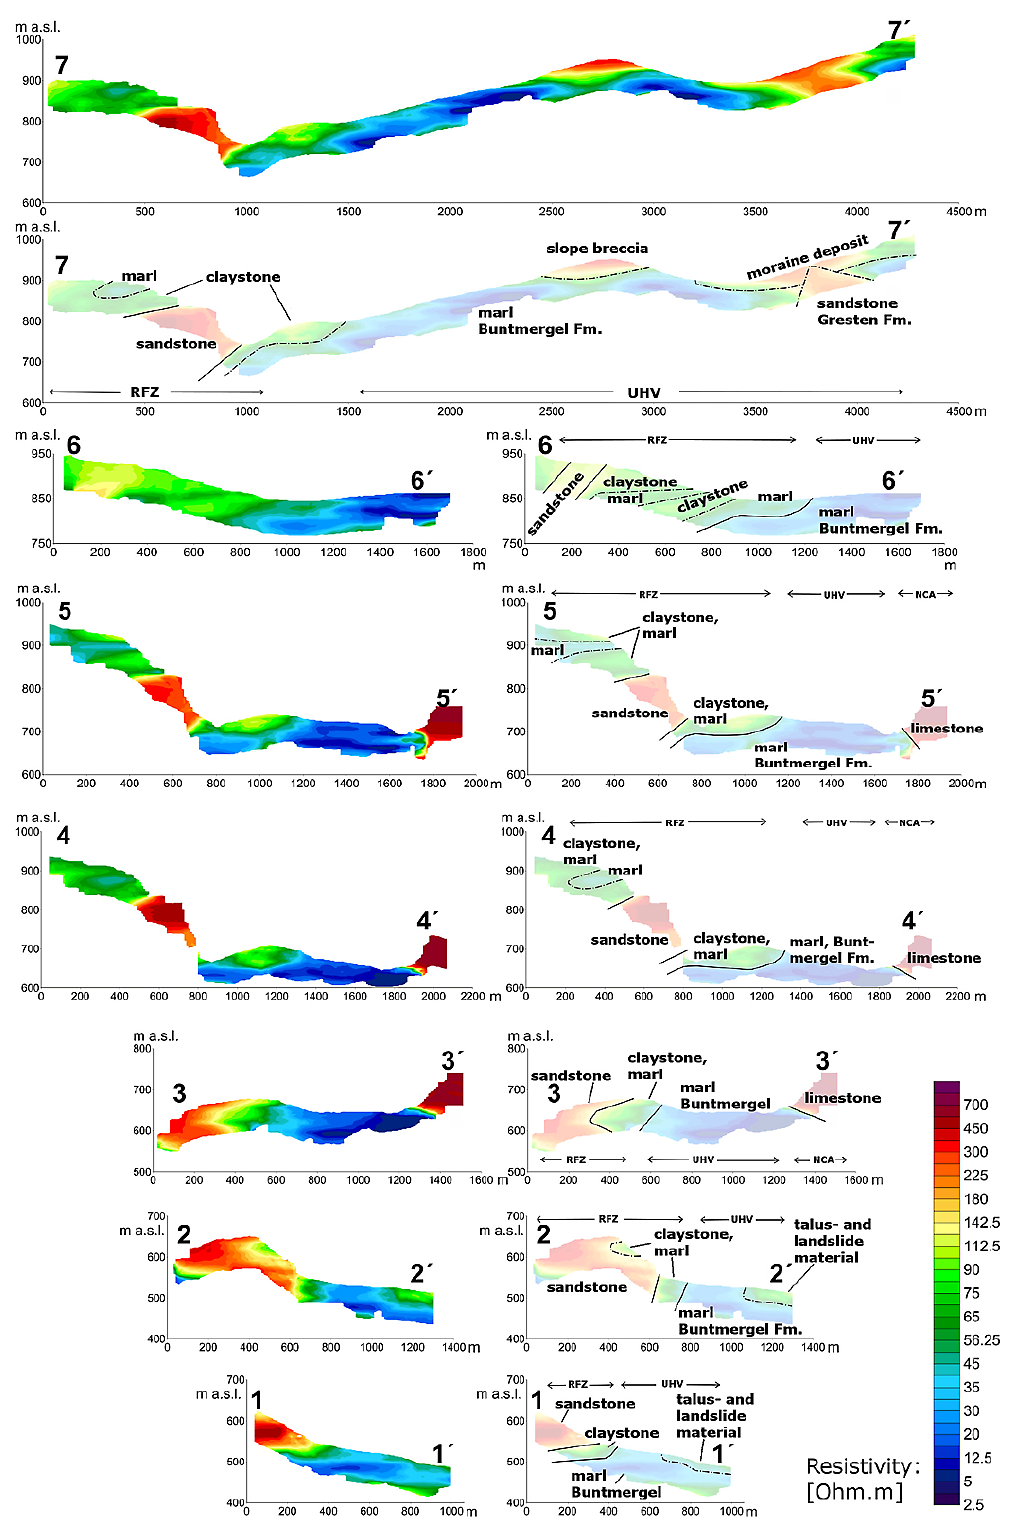
Fig. 8. HEM cross sections obtained from the 1-D multilayer inversions; their positions are marked in Fig. 9 (black lines); HEM cross sections with lower colour contrast include geological information for a detailed interpretation of the derived resistivity